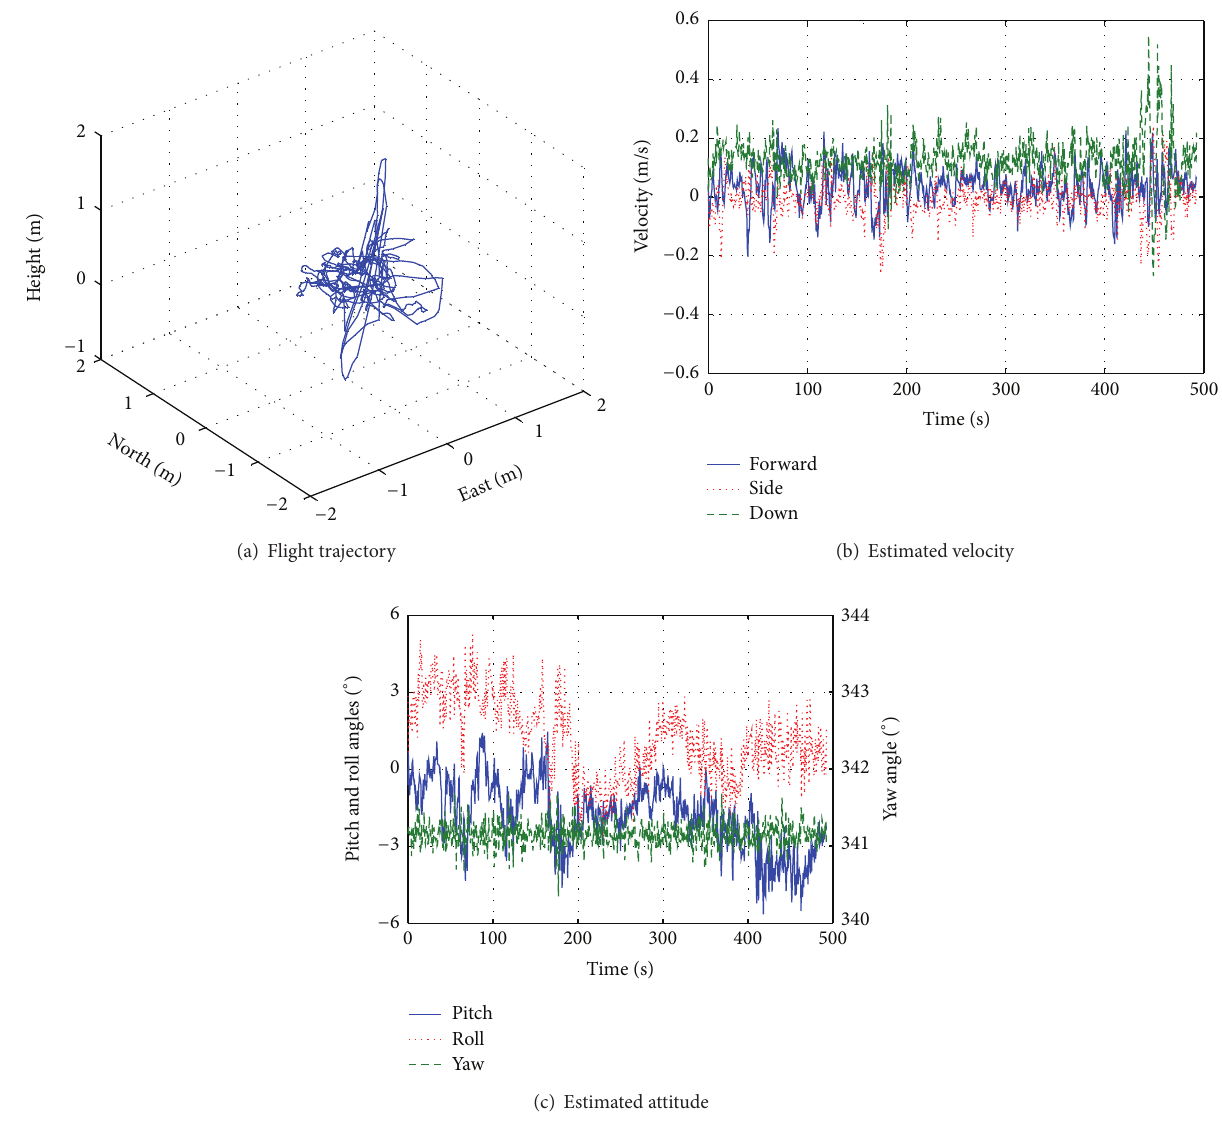
Figure 13: Estimated flight states of quadrotor in hovering